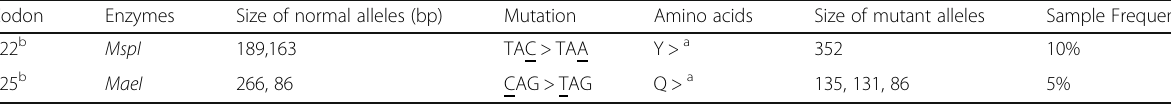
Table 1 Somatic mutational profiling of APC gene exon 14 using PCR-RFLP Codon